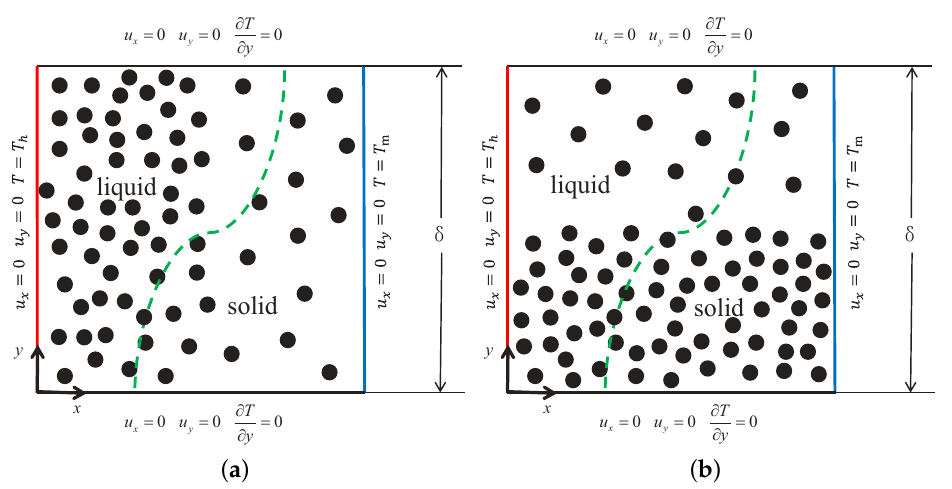
Figure 1. Schematic of solid–liquid phase change in gradient porous media, in which the porous media consists of various solid particles denoted by black spots, and the dash line represents the solid–liquid interface: ( a ) Case A: horizontal porosity gradient; ( b ) Case B: vertical porosity